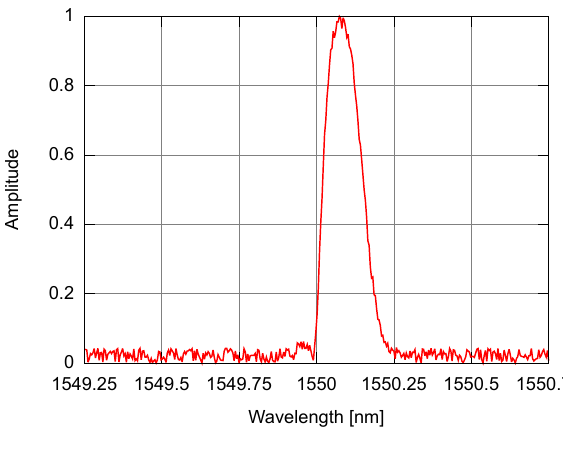
Figure 4. Example of optical spectrum for an FBG with gaussian modulation index profile and